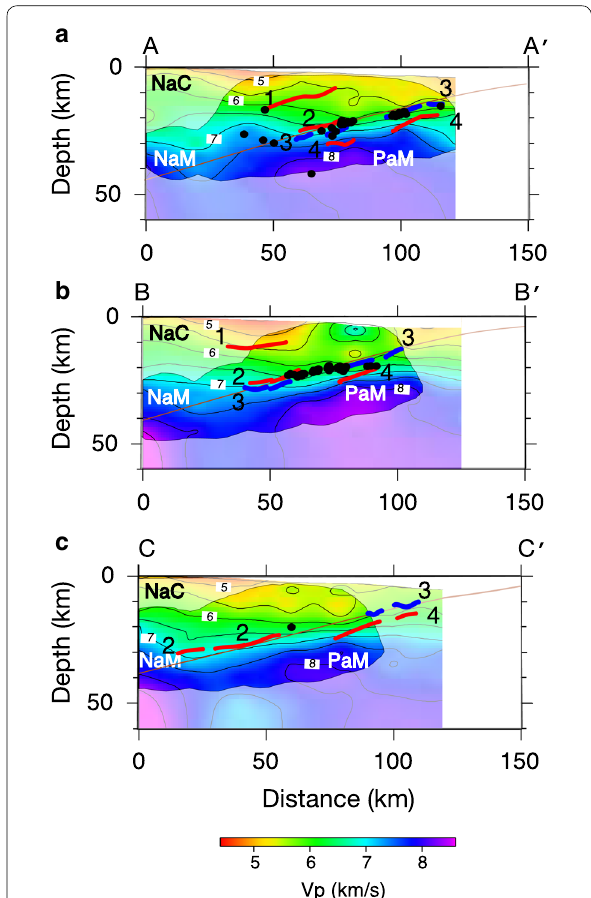
Fig. 10 The major phases in the depth-domain RFs superimposed on the velocity structure in the northern part of the studied area. The major phases are the same as in Fig. 9. The black circles indicate the low-angle thrust-faulting earthquakes within 10 km of each